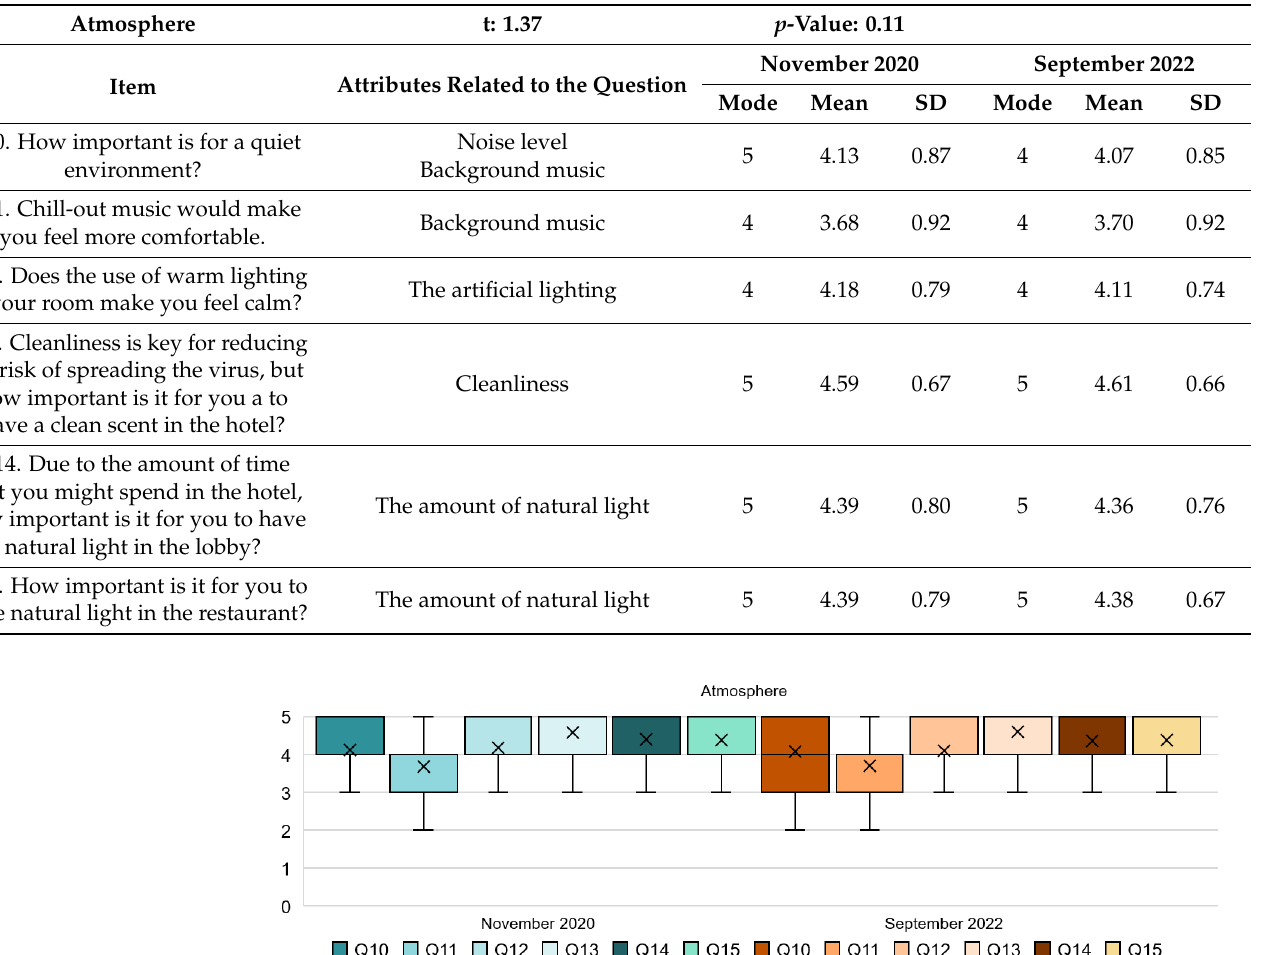
Figure 5. Interval data graph of the Atmosphere dimension.